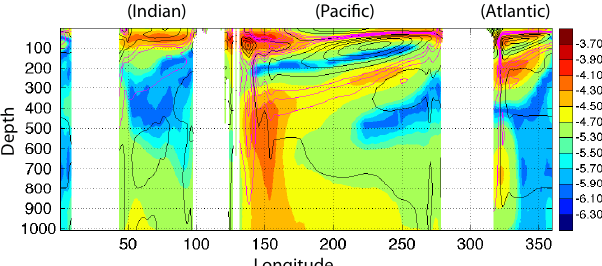
Figure 10. Estimated diapycnal diffusivity ( K d ) at the equator in m 2 s − 1 (log 10 color scale). Black and magenta contours denote the time mean zonal velocity from the state estimate. Black contours are separated by 10cms − 1 whereas magenta contours are separated by 4cms − 1 in the range within ± 10cms − 1